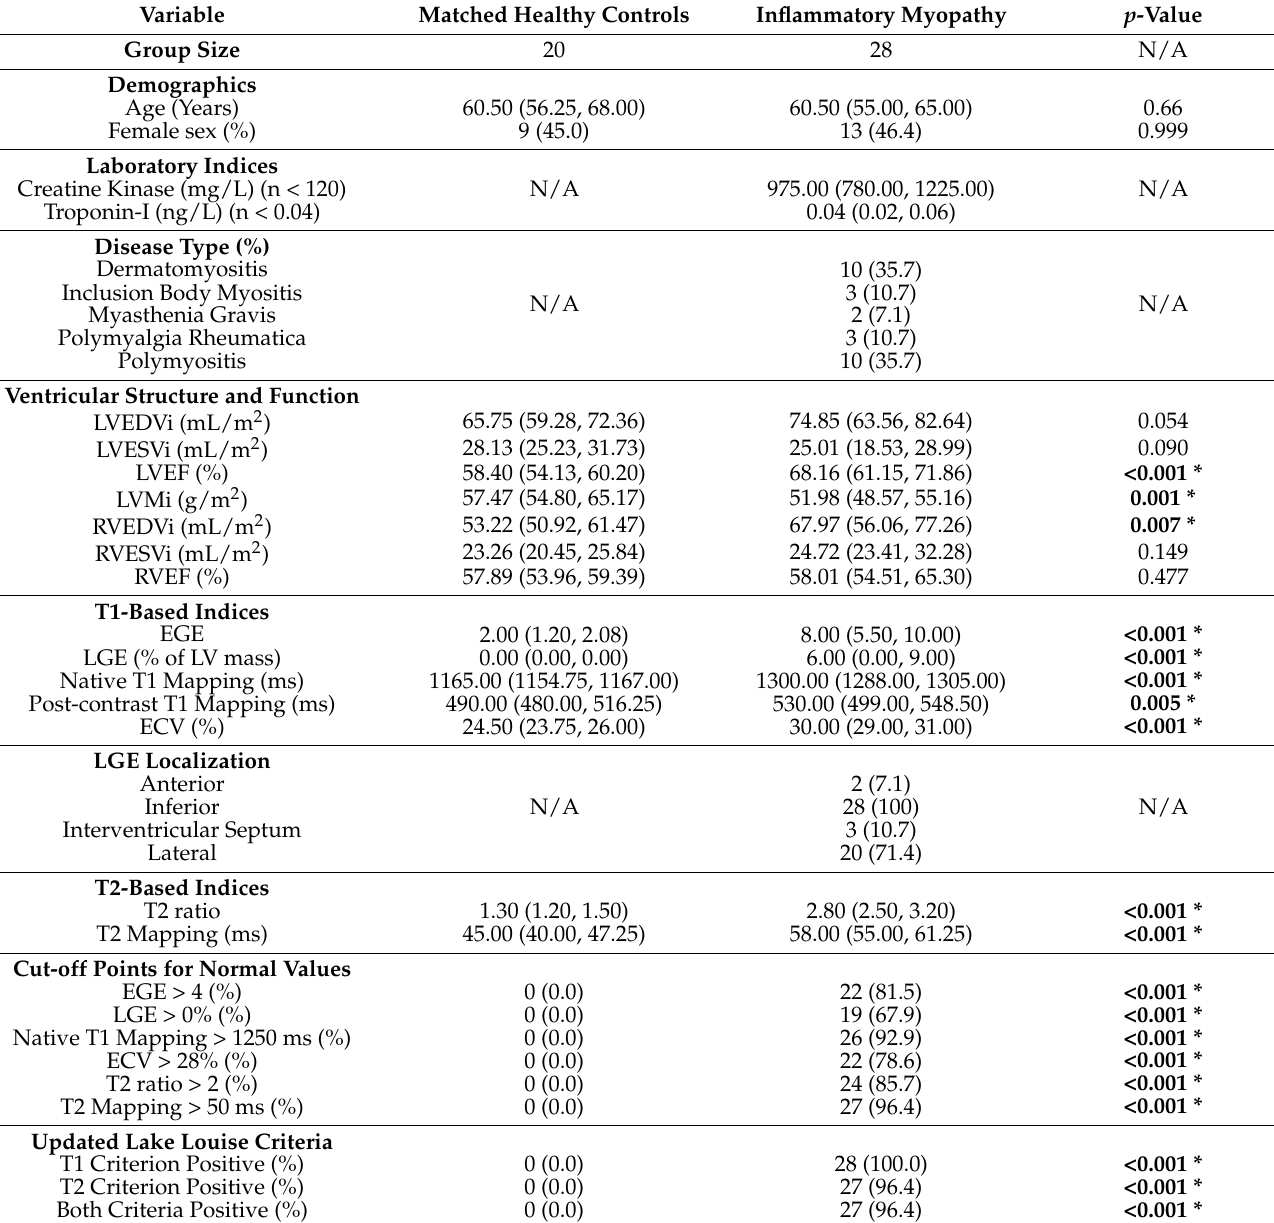
Table 2. Comparison of patients with inflammatory cardiomyopathy with their corresponding healthy control group. * p ≤